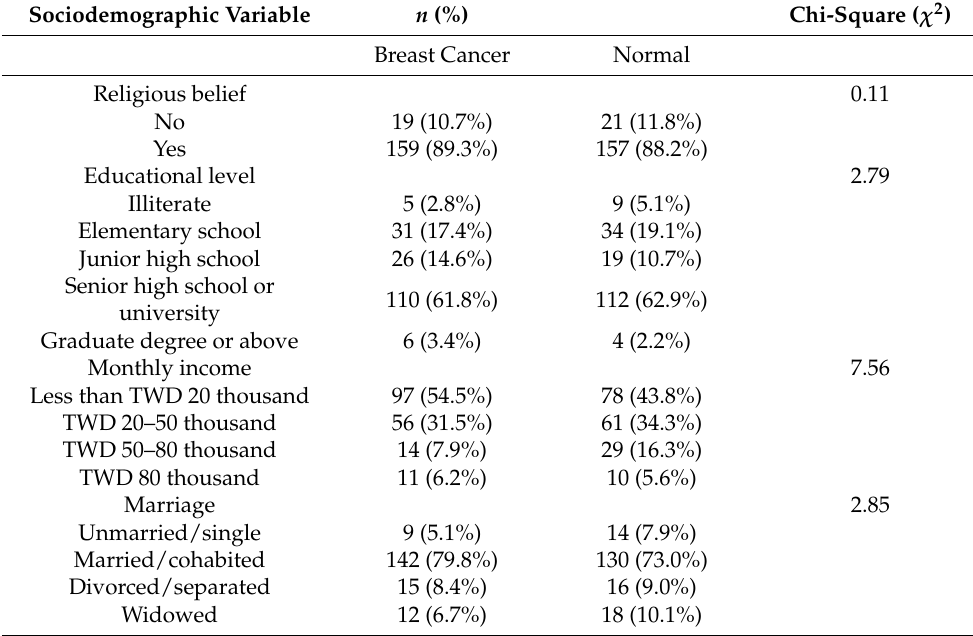
Table 1. Sociodemographic information of the participants ( n = 356).